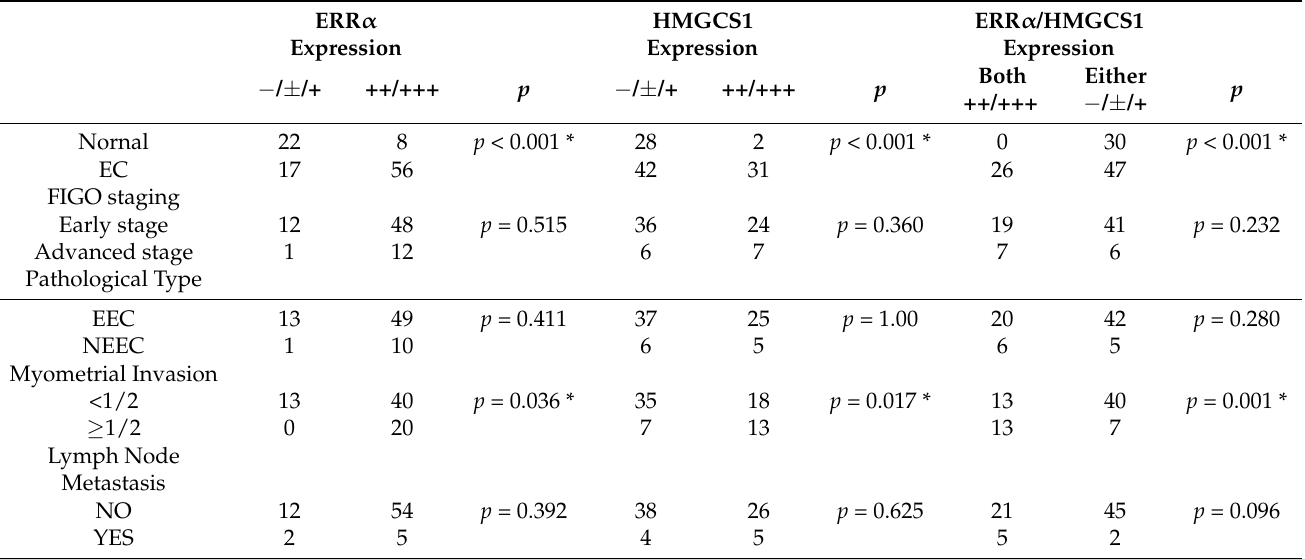
Table 2. Association between ERR α , HMGCS1 and ERR α /HMGCS1 expression and clinical variables in a tissue microarray of endometrial cancer and control tissues.